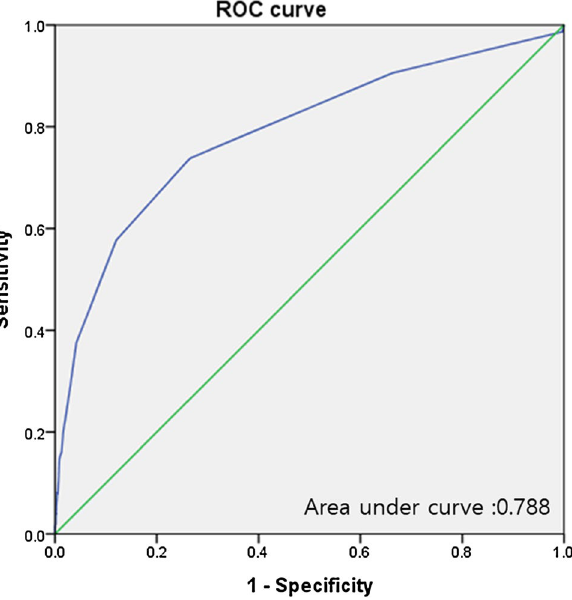
Figure 5. Receiver-operating characteristic plots of neutrophil–lymphocyte ratio associated with 1-year mortality for plastic and reconstructive